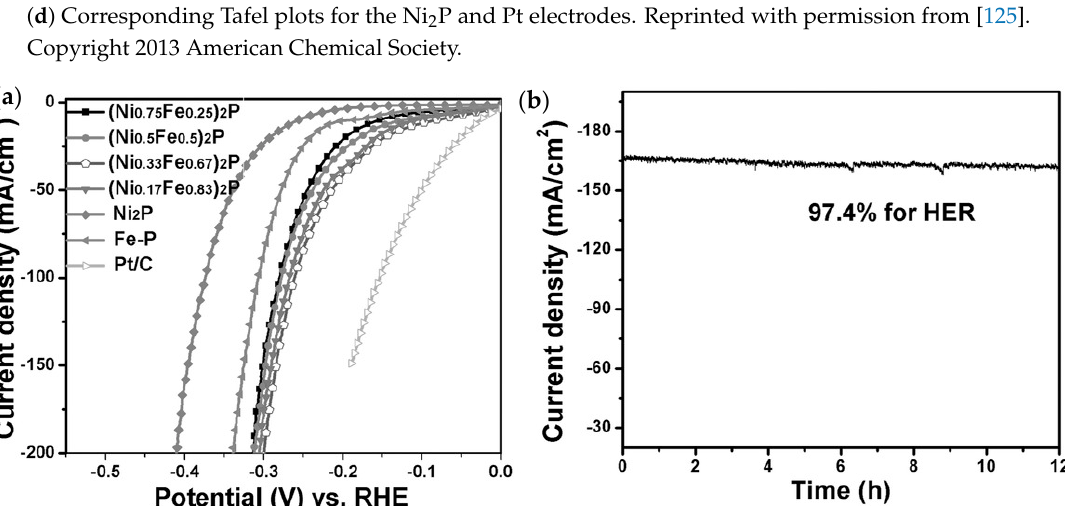
Figure 8. ( a ) Polarization curves of a series of (Ni x Fe 1 − x ) 2 P and commercial Pt/C electrodes for HER at a scan rate of 5 mV/s. ( b ) Time-dependent current density curve of (Ni 0.33 Fe 0.67 ) 2 P at a constant overpotential of ≈ 285 mV. Reprinted with permission from [128]. Copyright 2017 WILEY-VCH Verlag GmbH & Co. KGaA, Weinheim.